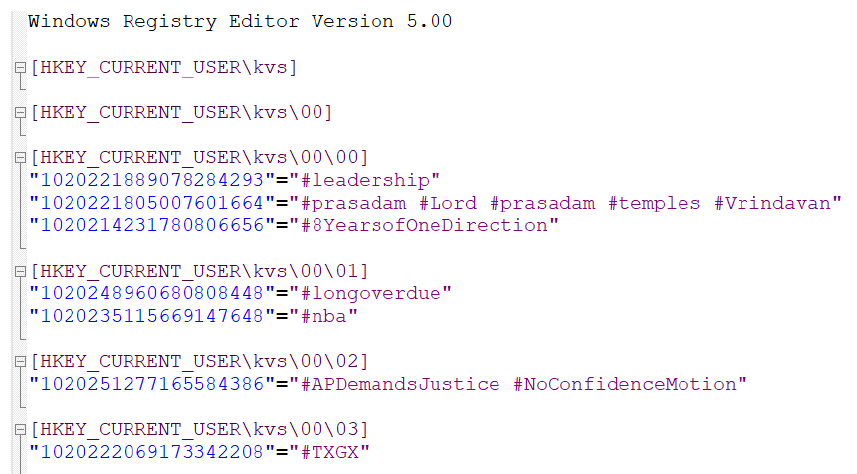
Figure 14. The details of data extracted from WR-Store (Data set: ID - HashTag